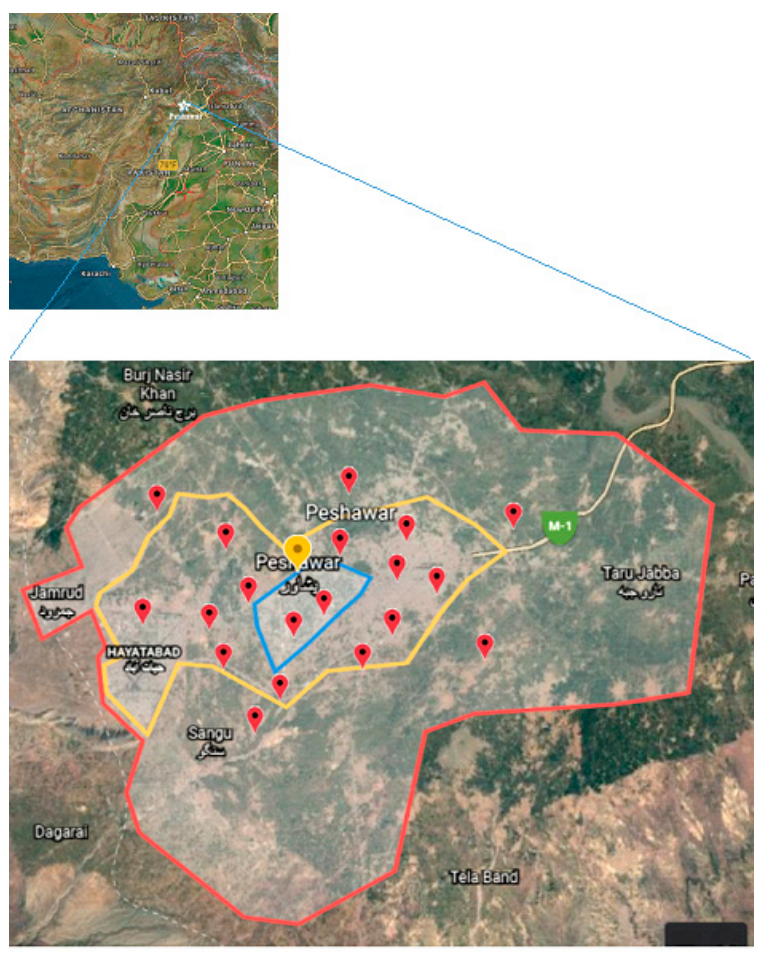
Figure 1. Map of Peshawar city showing geographical locations of sample collection